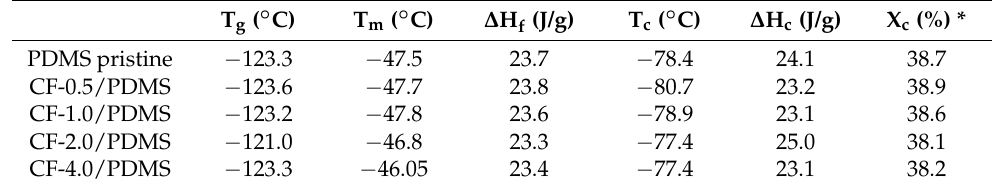
Figure 8. Differential scanning calorimetry curves for PDMS pristine and CF/PDMS samples. Table 3. Physical Properties of PDMS pristine and CF/PDMS samples by DSC.